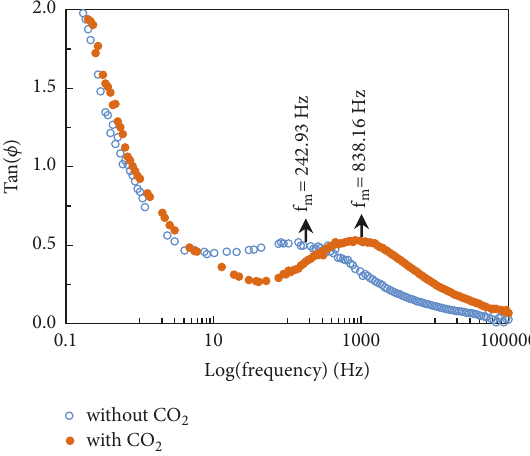
Figure 8: Loss tangent graph versus the logarithm of the frequency of Z5A-1 before and after adsorption of CO 2 at 433